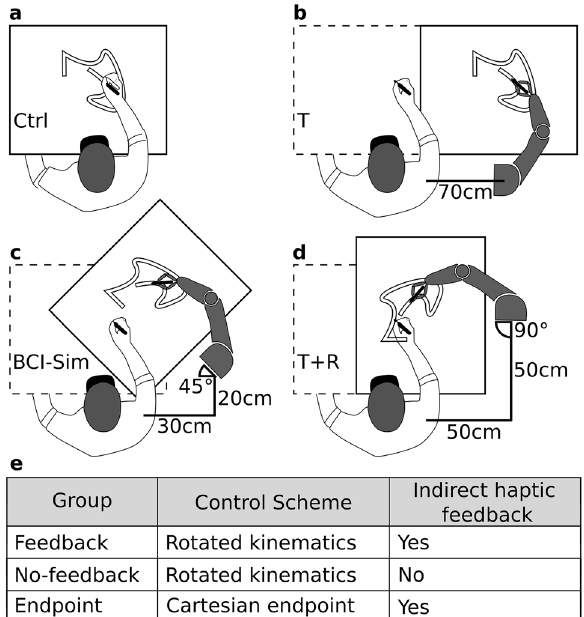
Figure 2. Schematic overview for the different conditions. Ctrl is shown in a, translation in b, BCI-Sim in c and the T + R condition in d. For the latter three conditions, the positioning of the robot arm relative to the participant’s shoulder are presented in the figure (the distances shown are not to scale). The virtual table’s position is marked with a black outline. The different combinations of haptic feedback and control schemes are shown in e . The with-feedback group performed the experiment with a real table matching the virtual table’s height. The real table’s position remained unchanged and is marked with dashed lines (for all conditions except